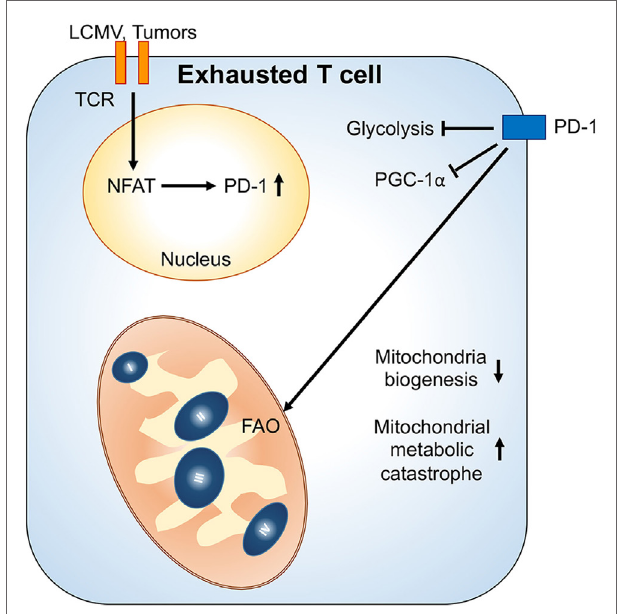
FiGURe 2 | Mitochondrial metabolic reprogramming under exhaustion of T cells . Upon chronic antigenic stresses such as lymphocytic choriomeningitis virus (LCMV) clone 13 infection and tumors, sustained T cell receptor (TCR) activation leads to NFAT-mediated programmed cell death protein 1 (PD-1) upregulation. Upregulation of PD-1 and chronic TCR activation suppress PGC1 α expression, leading to decrease of mitochondrial biogenesis. Moreover, PD-1 signal would suppress glycolysis and promote mitochondrial metabolism toward fatty acid oxidation (FAO). These metabolic reprogramming in mitochondria may further cause mitochondrial metabolic catastrophe if there is overload of mitochondrial oxidative metabolisms without sufficient antioxidant